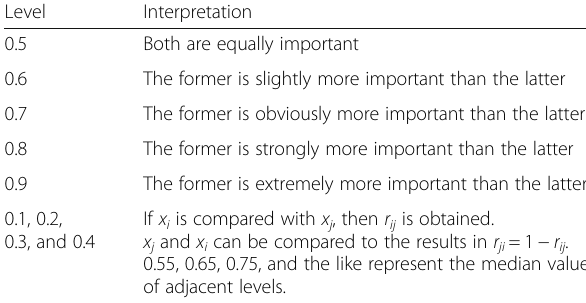
Table 6 Interpretation for importance level